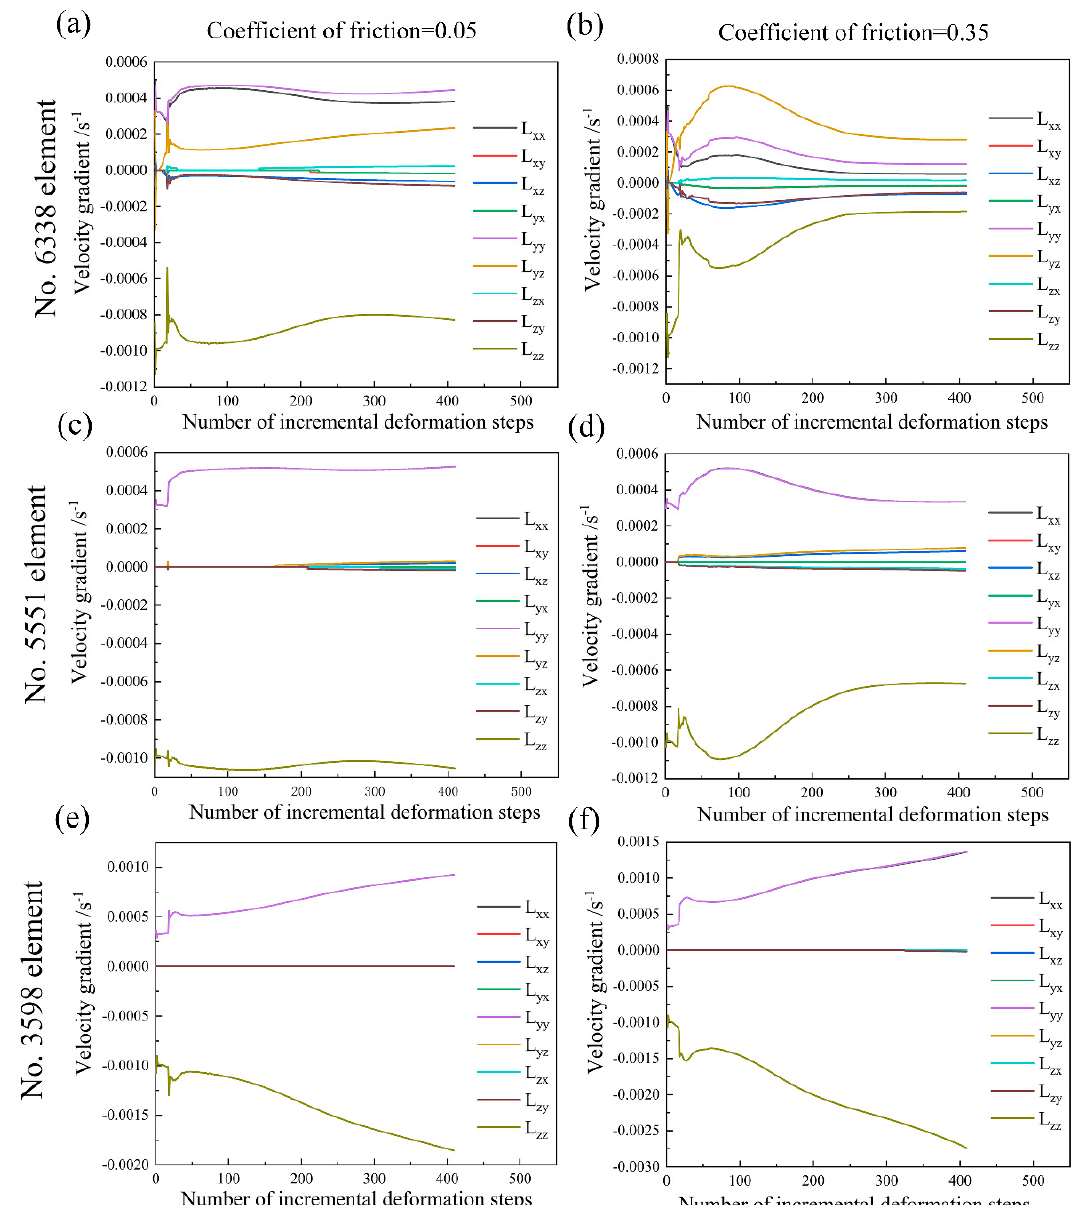
Figure 6. Velocity gradient in No. 6338 element, No. 5551 element and No. 3598 element during uniaxial compression at the deformation degree of 20% with: ( a , c , e ) Friction coefficient of 0.05; ( b , d , f ) Friction coefficient of 0.35.